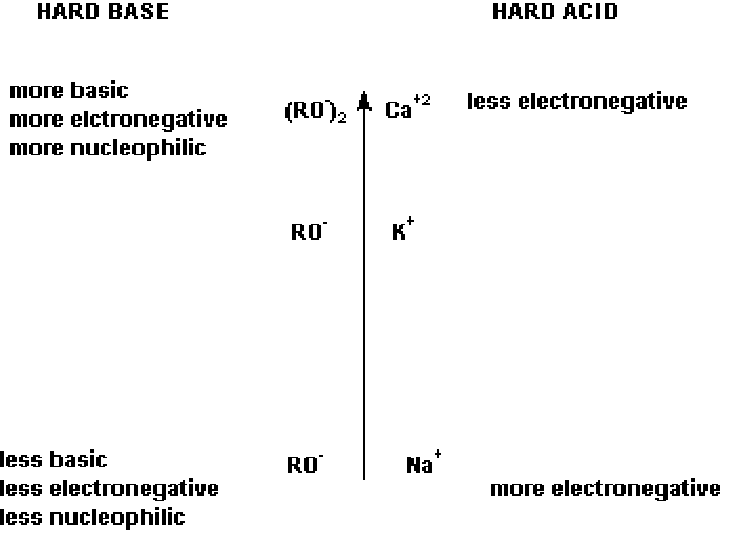
Figure 2. Lewis [12] and Pearson’s [13] representation of the “Hard-Soft-Acid-Base theory concerning anions and